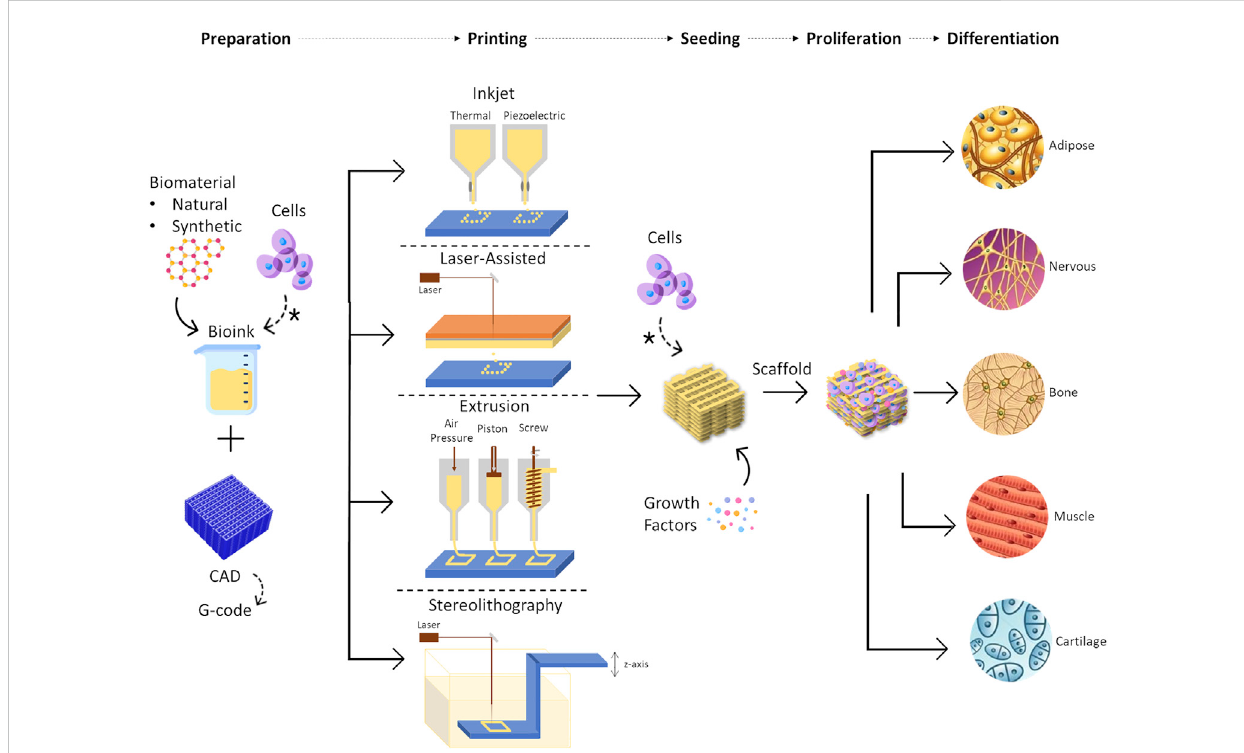
FIGURE 7 Representation of 3D bioprinting steps, including the different printing techniques that can be used, such as inkjet printing, laser-assisted printing, extrusion printing, and stereolithography. Some examples of tissues that can be regenerated using this approach are represented as the outcome of the process. * means cells can be placed at the beginning of the process, in solution with the biomaterial or they can be seeded into the scaffold after the printing